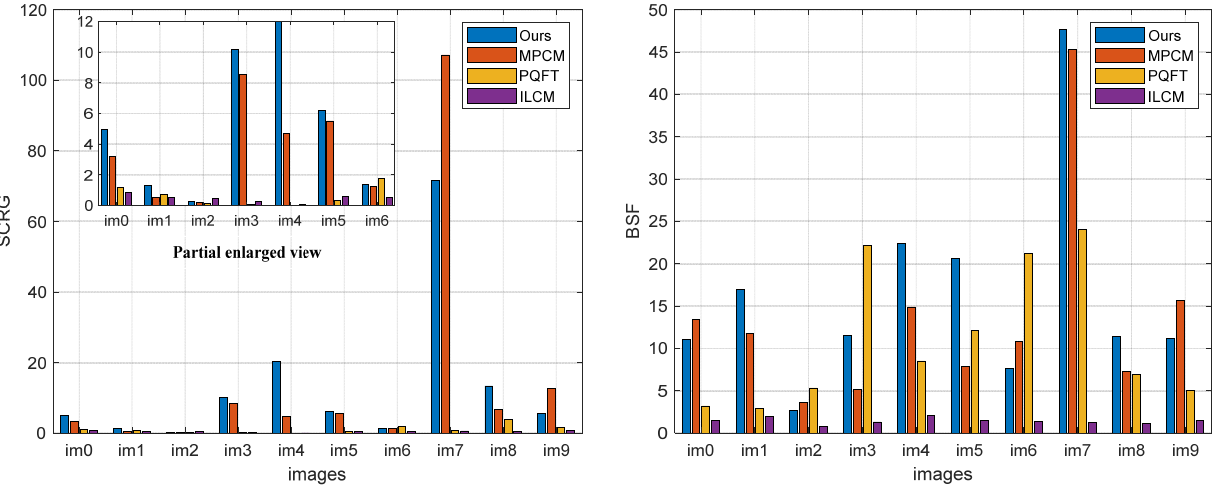
Figure 5. Values of SCRG and BSF for frames in Figure 3.